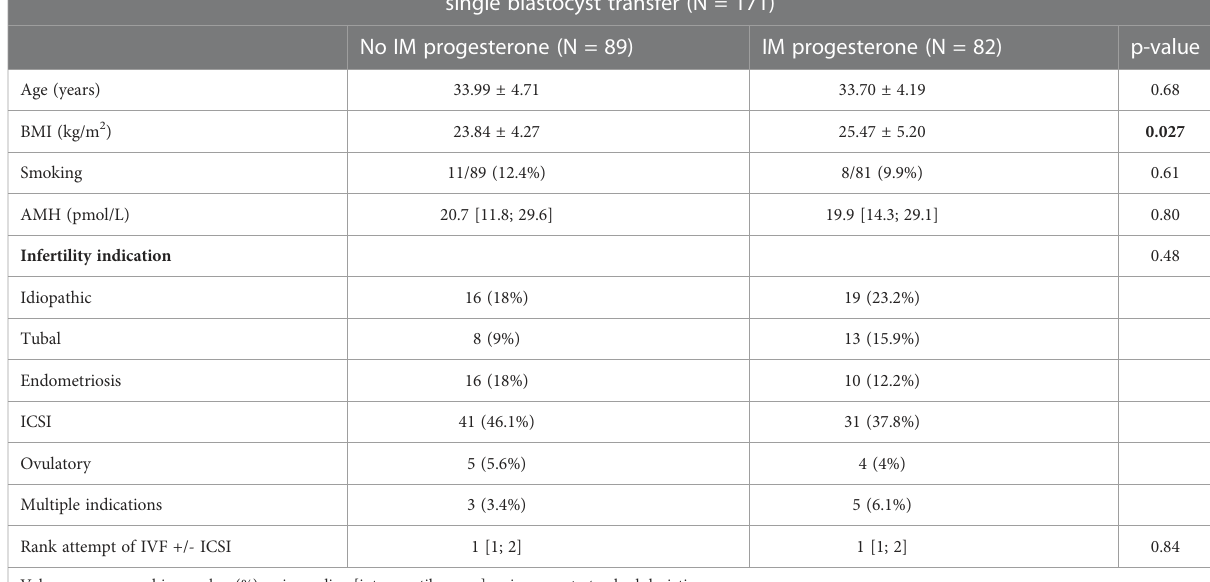
TABLE 1 Patients